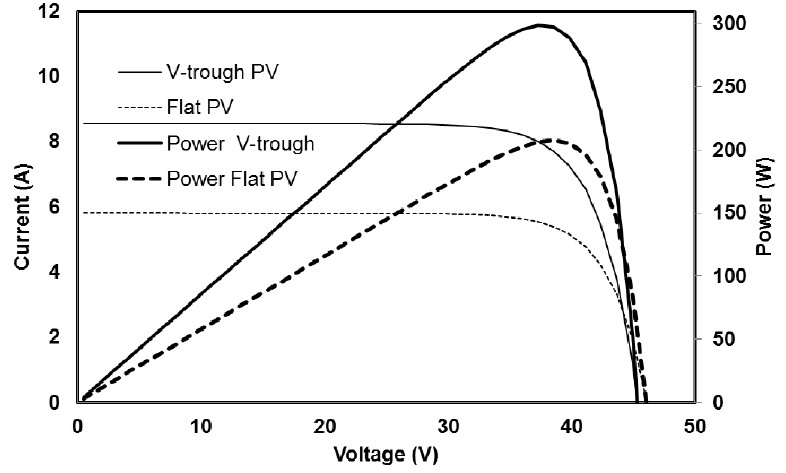
Figure 16. I-V and P-V curves for Flat PV and V-trough PV system